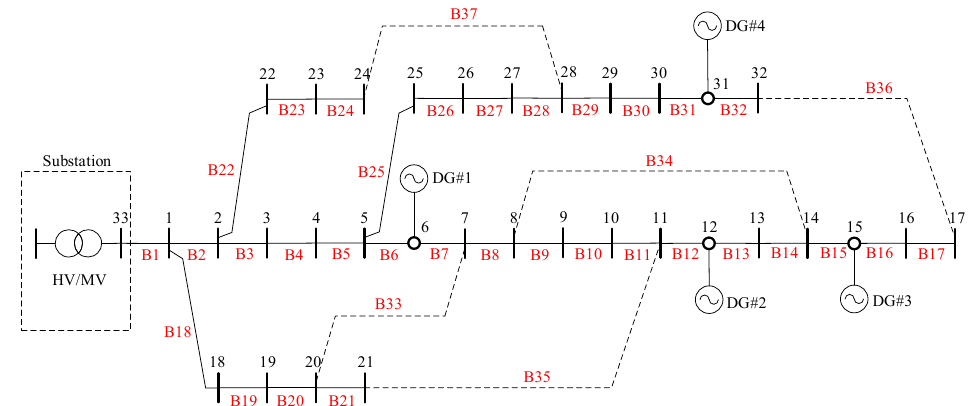
Figure 6. MV 33-bus distribution system in the modified form.